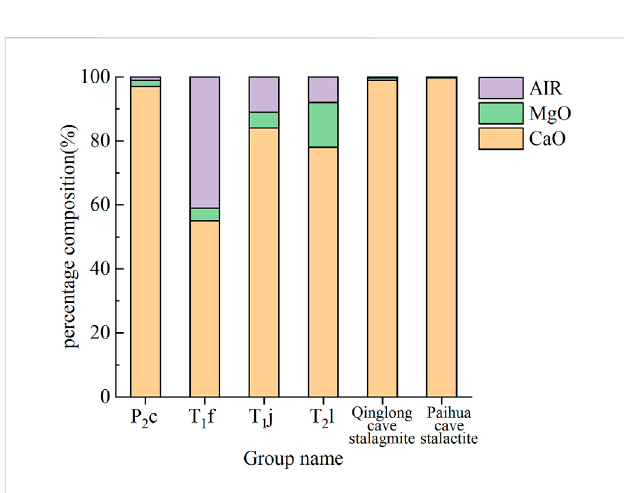
FIGURE 3 Carbonated rocks composition of water-bearing formation and two karst